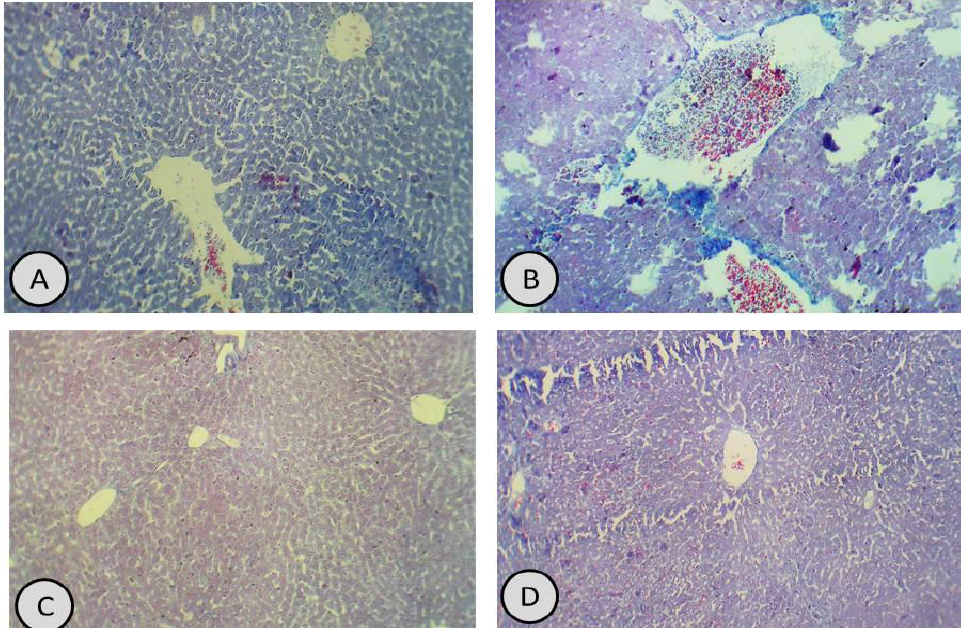
Figure 6. Photomicrographs of heart sections: ( A ) control group showed normal cardiac muscles and fibres (H&E×400); ( B ) CdCl 2 group showed interstitial inflammatory cells (arrow) and muscle fibre disruption with interstitial haemorrhage ( * ) (H&E×400); ( C ) R. damascena group showed normal cardiac muscle fibres (H&E×400); ( D ) group treated with R. damascena in combination with CdCl 2 showed restoration of cardiac muscle structure with appearance of interstitial inflammation (thin arrow) H&E×400).